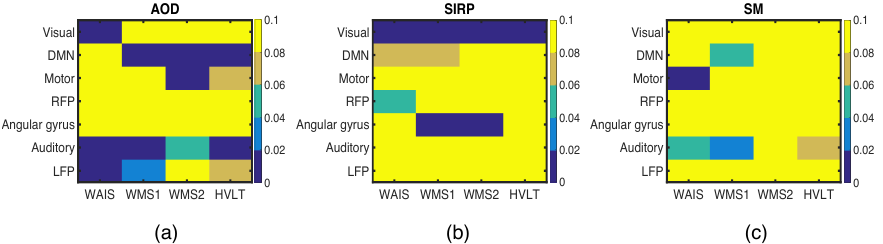
Figure 10. Behavioral features and neuroimaging components identified as correlated using one- to-one Pearson correlation technique across ( a ) AOD, ( b ) SIRP, and ( c ) SM task datasets. Here, we are showing p -values of the correlation and use p < 0.05 as a threshold to identify the significantly correlated behavioral and neuroimaging